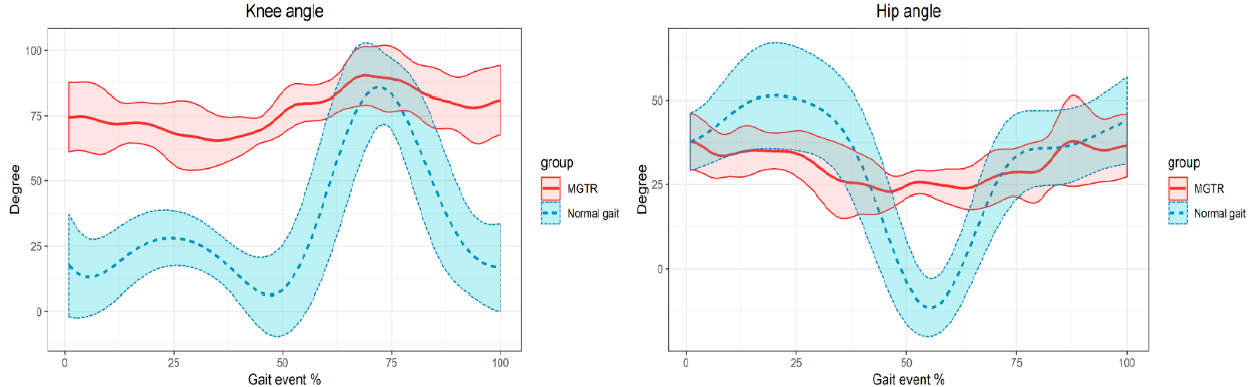
Figure 4. Results of the knee and hip angle with the gait cycle.